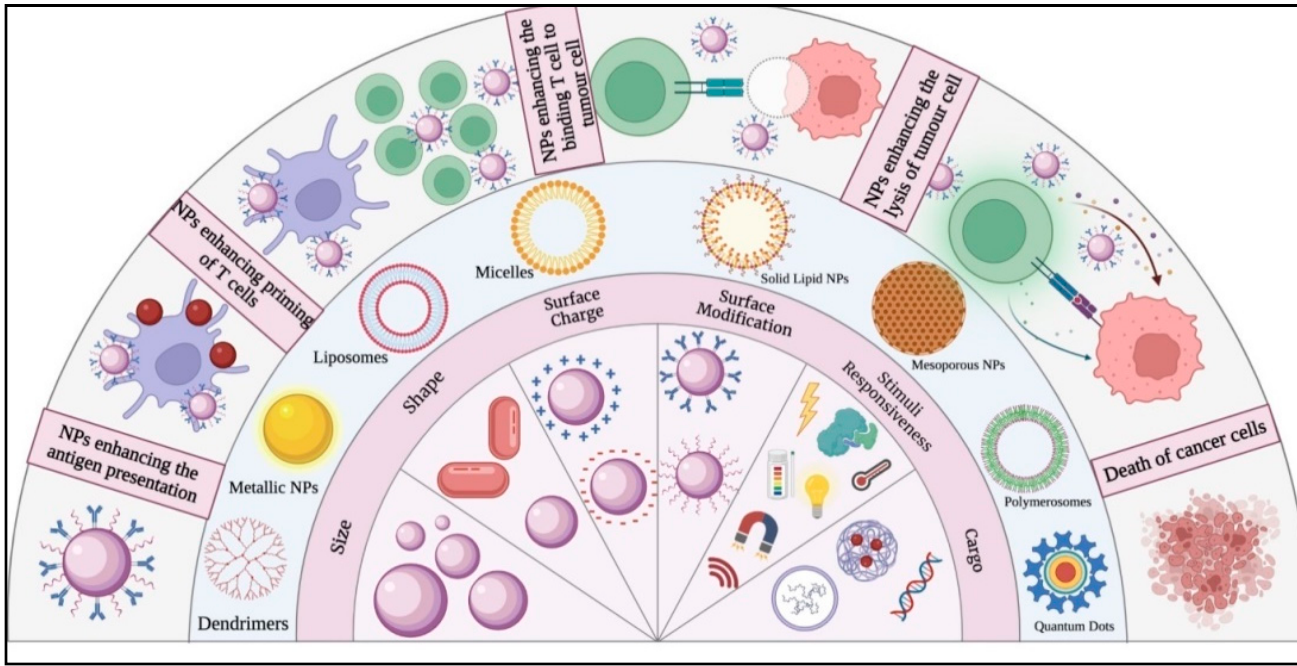
Figure 1. Recently explored nanoparticles for cancer immunotherapy using different strategies and modifications.